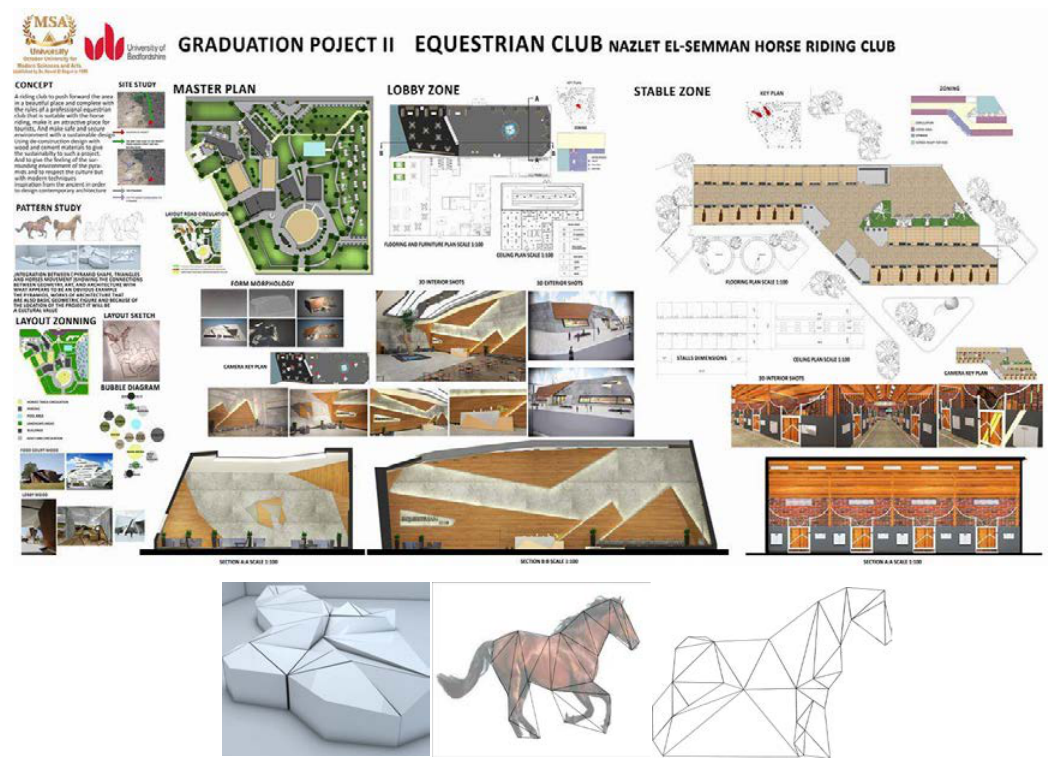
Figure (10): Nazlet El Semman Equestrian Club Grad. Project: the student has studied the area of Nazlet El semman and its problems and decided to design a project inspired by Pyramids and triangle shapes patterns of Arabian horse movement analysis. Source: Interior design Department digital archive library of Grad. Projects